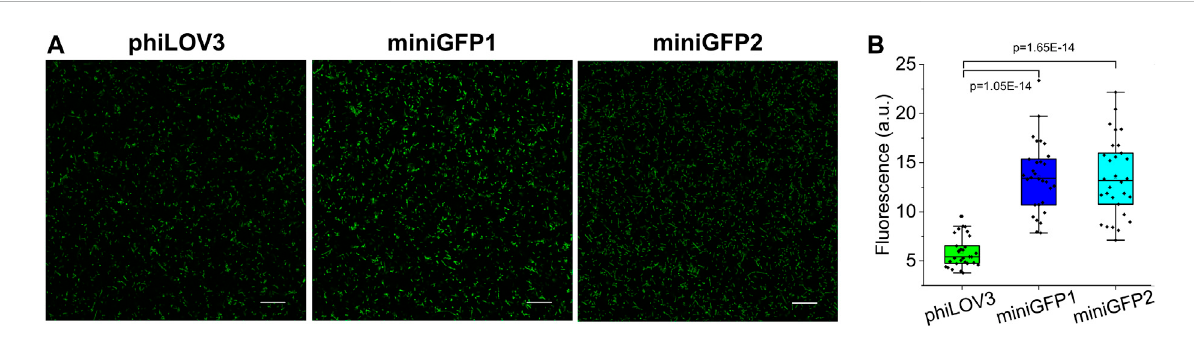
FIGURE 4 Characterization of miniGFPs under anaerobic conditions. (A) Fluorescence confocal images of anaerobically cultured E. coli cells expressing phiLOV3,miniGFP1,andminiGFP2.Scalebar,20 µm. (B) Quanti fi ed fl uorescenceof E.coli expressingproteinsshownin (A) (P miniGFP1-phiLOV3 =1.05E- 14, P miniGFP2-phiLOV3 = 1.65E-14, ANOVA — Fisher